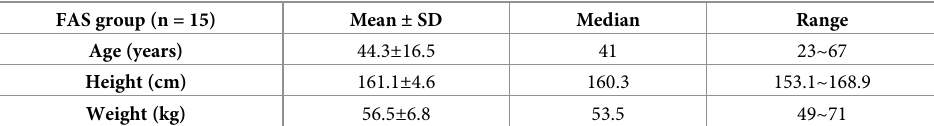
Table 1. Demographic characteristics of subjects.